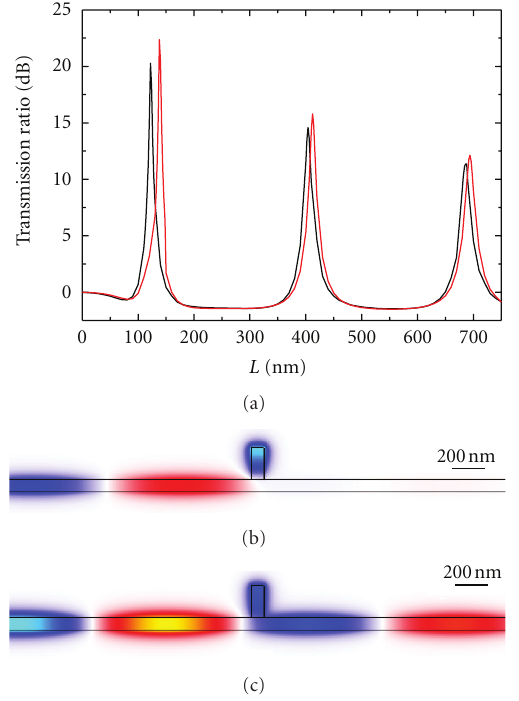
Figure 6: (a) Modulation depth T ( κ = 1) /T ( κ = 0) of the side-coupled-cavity switch (Figure 5(a)) as a function of the stub length L calculated using FDFD (black curve), and transmission line theory (red curve). Results are shown for w = 50nm. All other parameters are as in Figure 5(b). (b) Magnetic field profile of the switch for L = 120nm in the absence of pumping ( κ = 0). All other parameters are as in (a). (c) Magnetic field profile of the switch in the presence of pumping ( κ = 1). All other parameters are as in (b).